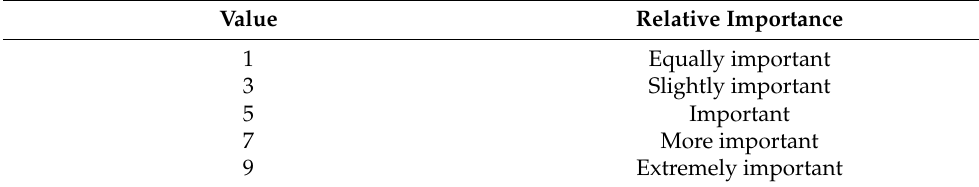
Table 6. Classification of the relative importance of indexes.